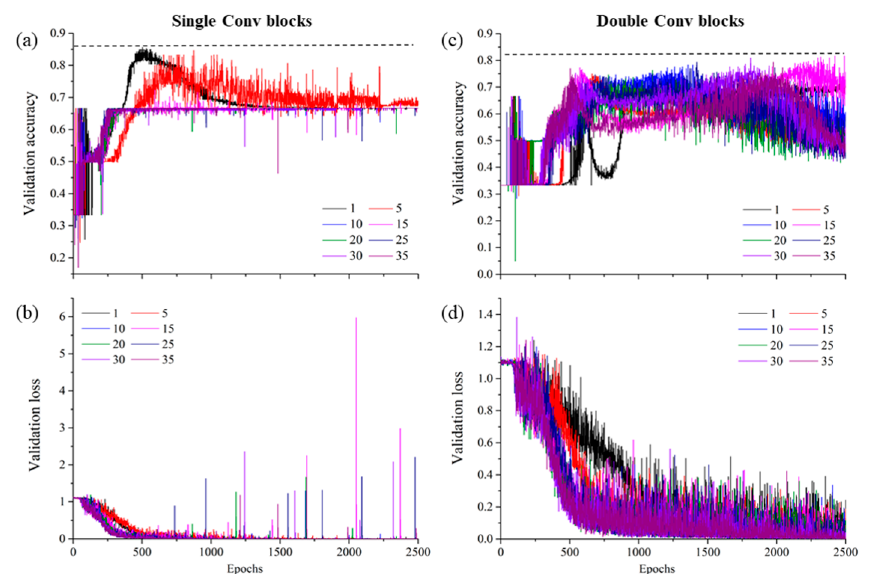
Figure 10. ( a ) The accuracy of Single Conv block corresponding to different channel numbers; ( b ) The loss of Single Conv block corresponding to different channel numbers; ( c ) The accuracy of Double Conv block corresponding to different channel numbers; ( d ) The accuracy of Double Conv block corresponding to different channel numbers. (Lines of different colors represent different channel numbers.).